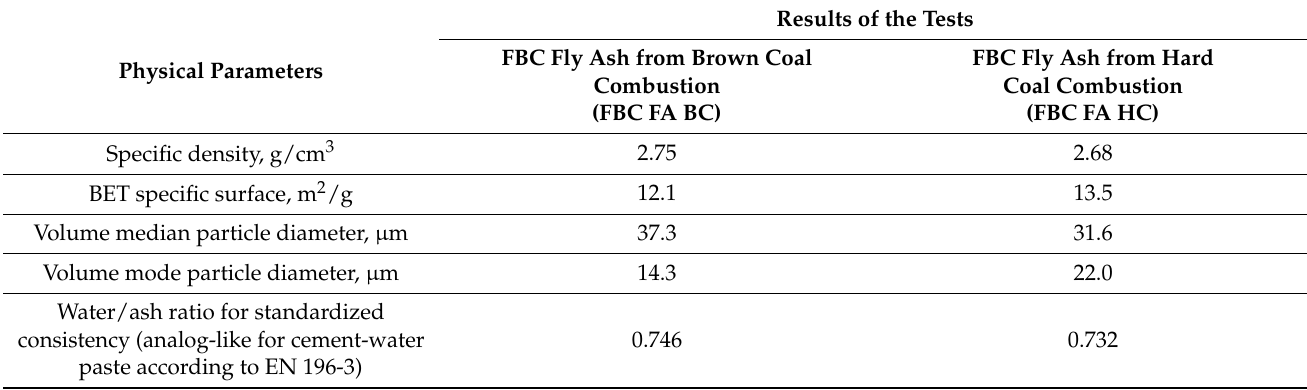
Table 2. Physical parameters of the two types of FBC fly ash obtained from brown and hard coal combustion.